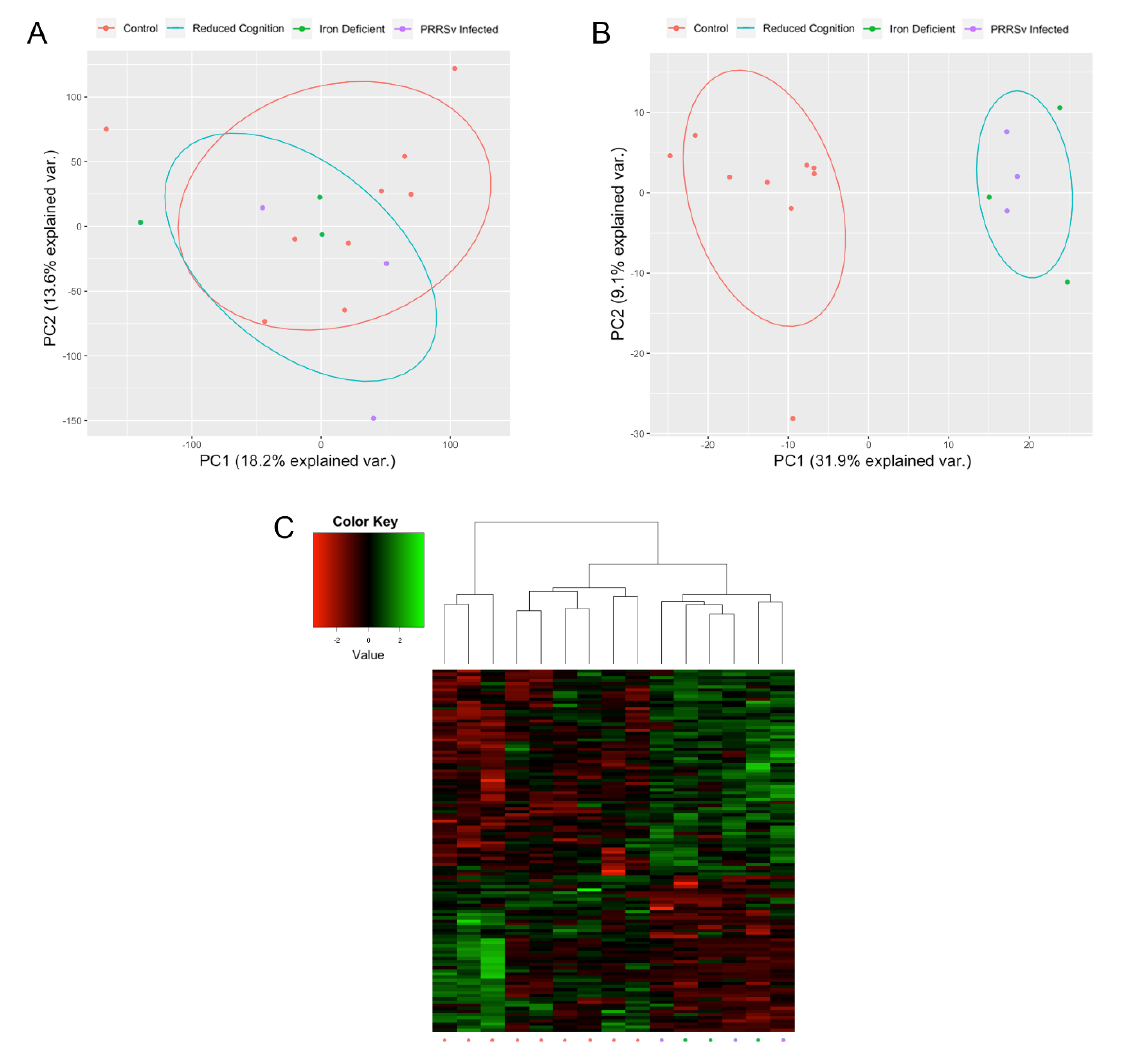
Figure 2. Altered Hippocampal DNA Methylation Patterns. PCA based on the methylation level of ( A ) all tested regions and ( B ) DMRs. ( C ) Heatmap of the methylation levels of the 116 DMRs, represented as z-scores.